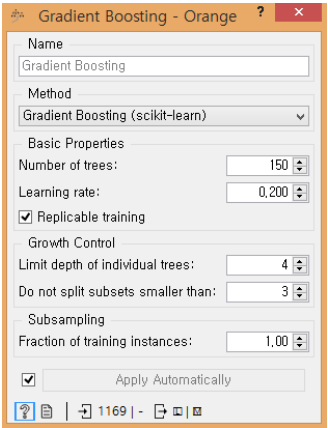
Figure 10. Parameters of the proposed gradient boosting model [79].